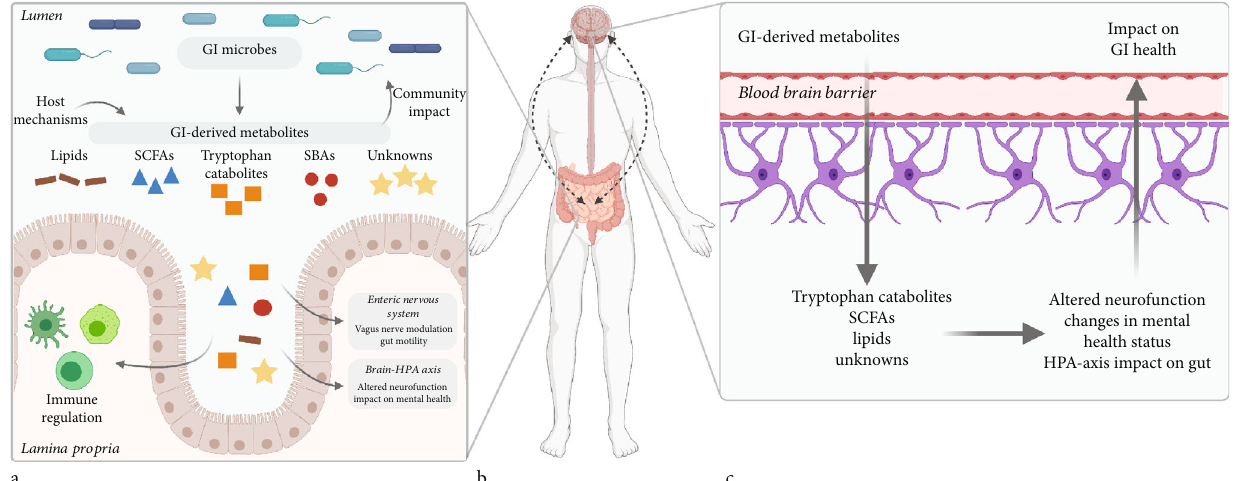
Figure 2: Overview of gastrointestinal-derived metabolites and their systemic impact. (a) GI microbes and host mechanisms drive production of metabolites that modulate processes such as immune function. Additionally, these molecules are transported systemically and impact the enteric nervous system and the brain-HPA axis. (b, c) Metabolites from the GI tract are transported to the brain, and those able to pass the BBB may impact neurofunction such as neurotransmitter receptor expression and mental health status. Changes in brain activity are then transported back to the GI tract which has been shown to impact functions such as gut motility and nutrient uptake. SCFAs: short chain fatty acids; SBAs: secondary bile acids; GI: gastrointestinal; HPA: hypothalamic-pituitary-axis ( fi gure created with